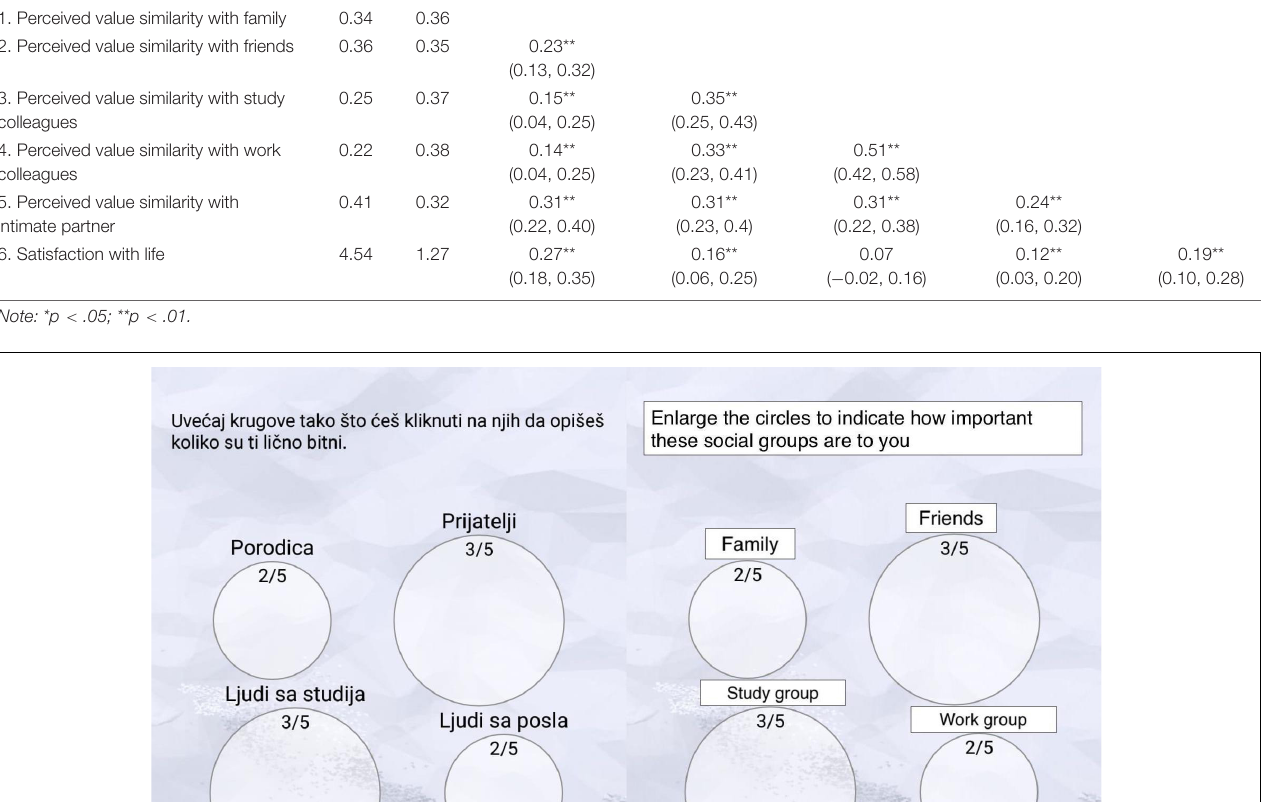
TABLE 3 | Means, standard deviations, and correlations with their confidence intervals. Variable